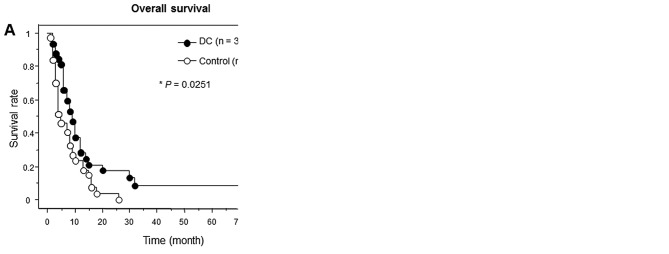
Survival time in melanoma patients given the DC vaccine Thirty-three metastatic melanoma patients enrolled in phase I–II trials were analyzed. Survival data derived from 37 cases of melanoma given best supportive care without DC vaccine were utilized as a control. (A) Survival analysis of melanoma patients with and without the DC vaccine. ○, without DC (n=37); ●, with DC (n=33). (B) Survival analysis for high (≥2) and low (<2) ELISPOT scores. ○, score <2 (n=15); ●, score ≥2 (n=18). The difference was analyzed using the log-rank test. Values of P<0.05 were considered statistically significant.